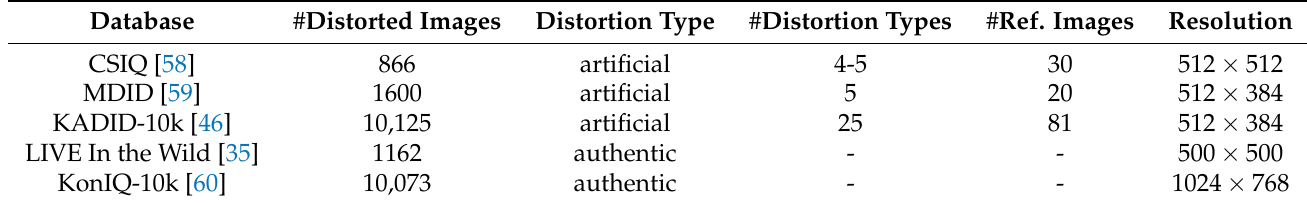
Table 4. Publicly available IQA benchmark databases used in this